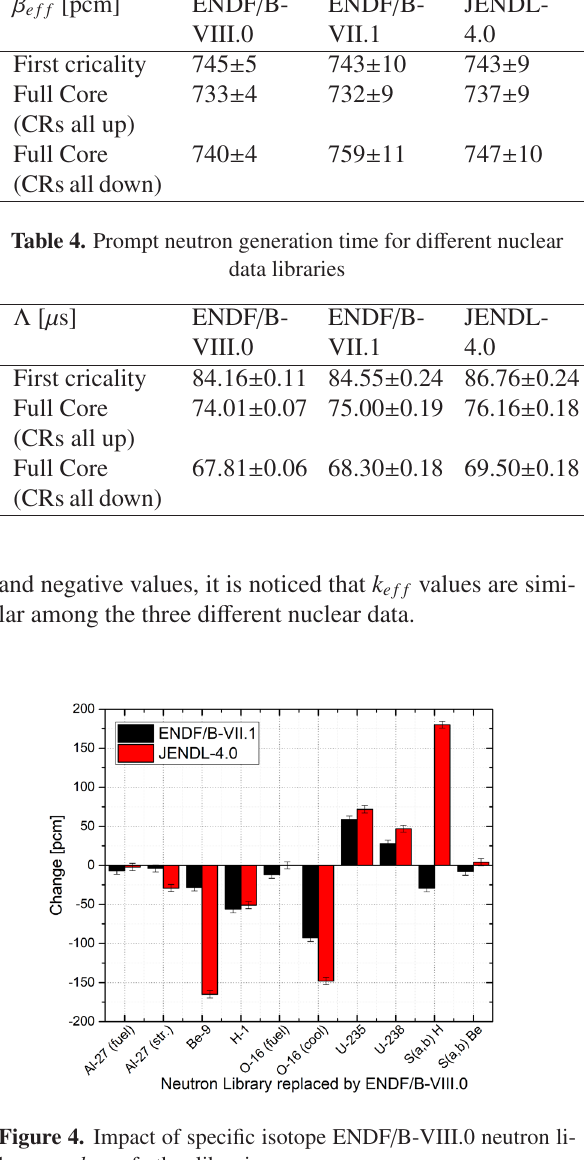
Figure 2. Full core configuration of RSG GAS first core [3]